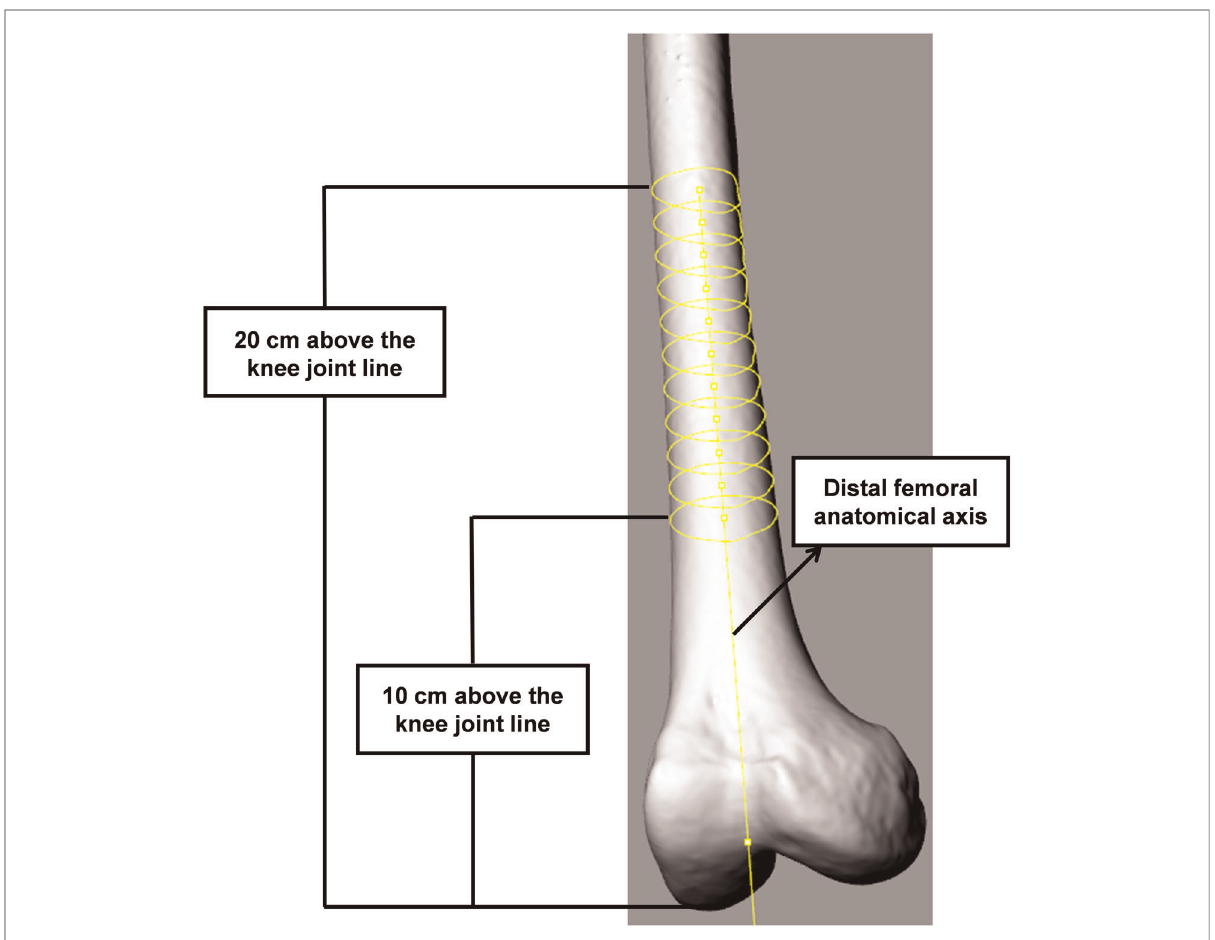
FIGURE 3 Identi fi cation of proper entry point. The anatomical axis was de fi ned as the line fi tted by the points of 10 isometric cross-sections of the femoral shaft at 10 and 20 cm above the distal femoral articular